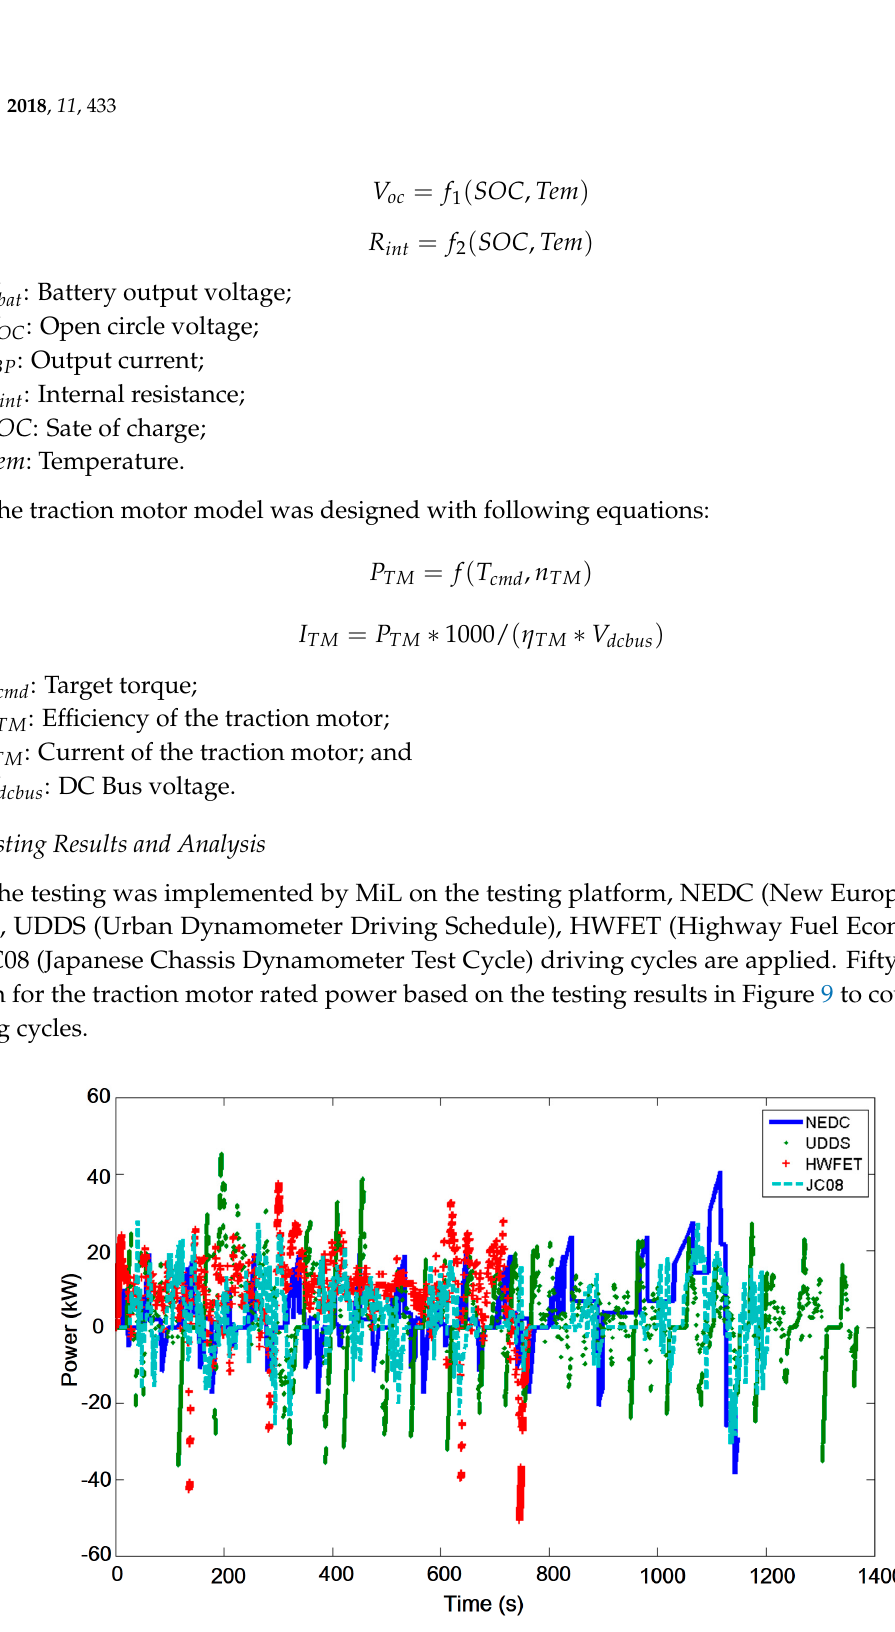
Figure 9. Requested traction motor output power in four typical driving cycles.